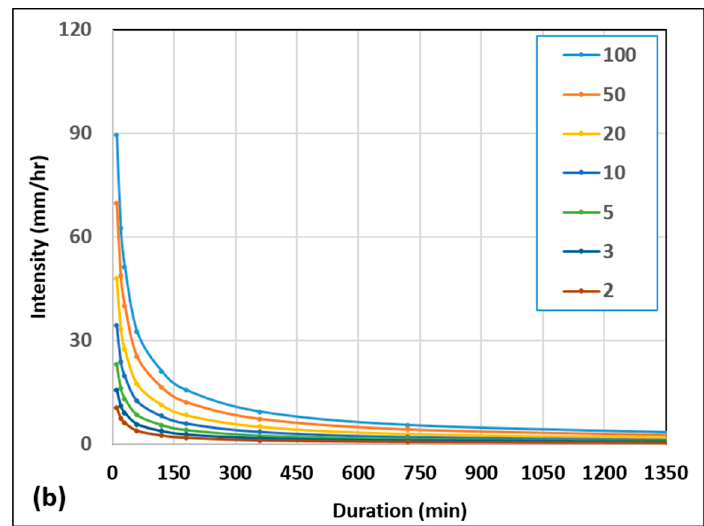
Figure 4. ( a ) Probability distribution curves at Tabuk Station (TB001) for maximum daily data using the log-normal method; ( b ) intensity–duration–frequency (IDF) curves of Tabuk City (TB001) intensity data during the period 1965 to 2004. Table 2. Rainfall depths of different return periods at Tabuk station (TB001).